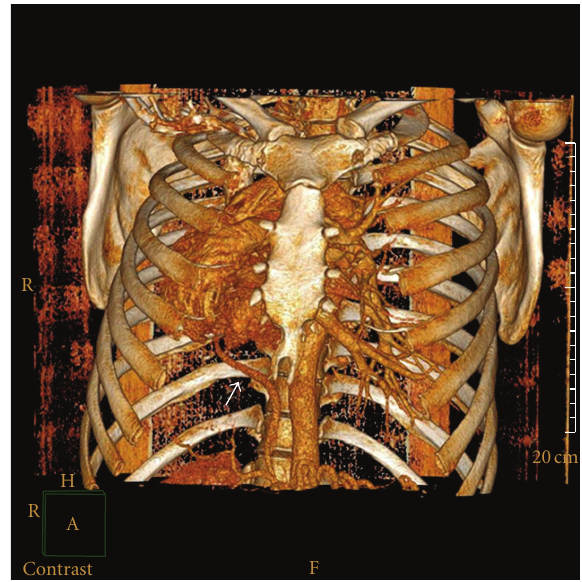
Figure 3: Three-dimensional reconstructed image showing the anomalous venous drainage (white arrow).